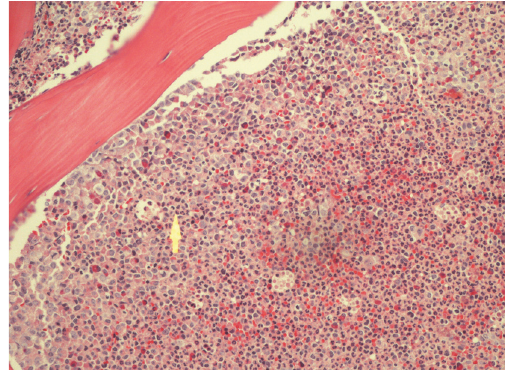
Figure 1: The bone marrow core biopsy H&E stain above shows a hypercellular marrow with 100% cellularity and an increase in granulocyte precursors. In addition, an increase in basophils, eosinophils, and an occasional monocyte and blast are also observed. The arrow points to granulocytes comprising most of the marrow.